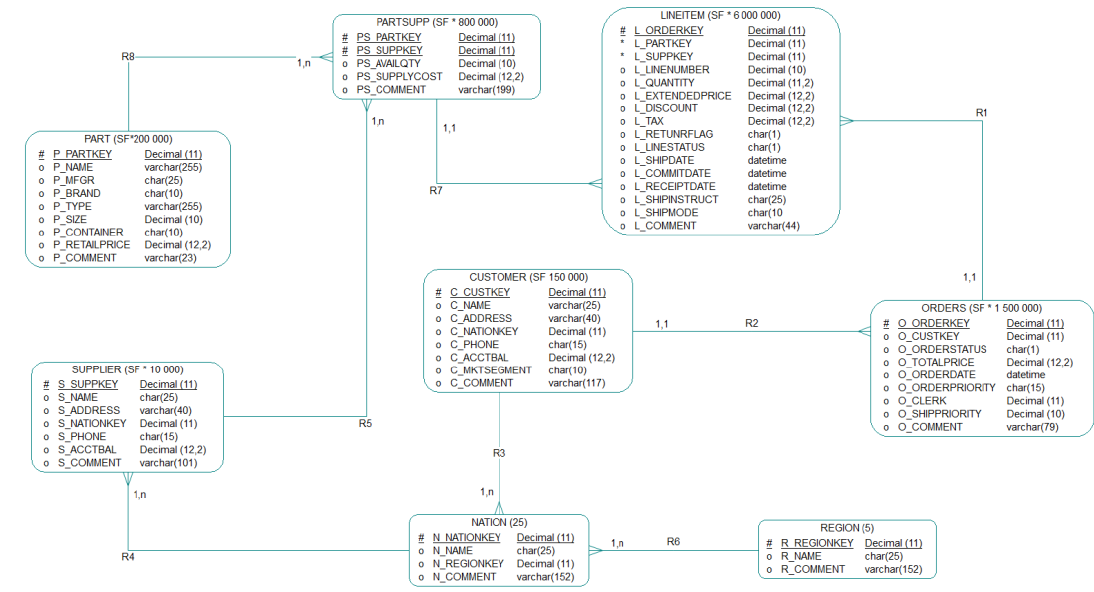
Figure 6. The components of TPC-H consisting of eight tables (adapted from p. 13). [1].